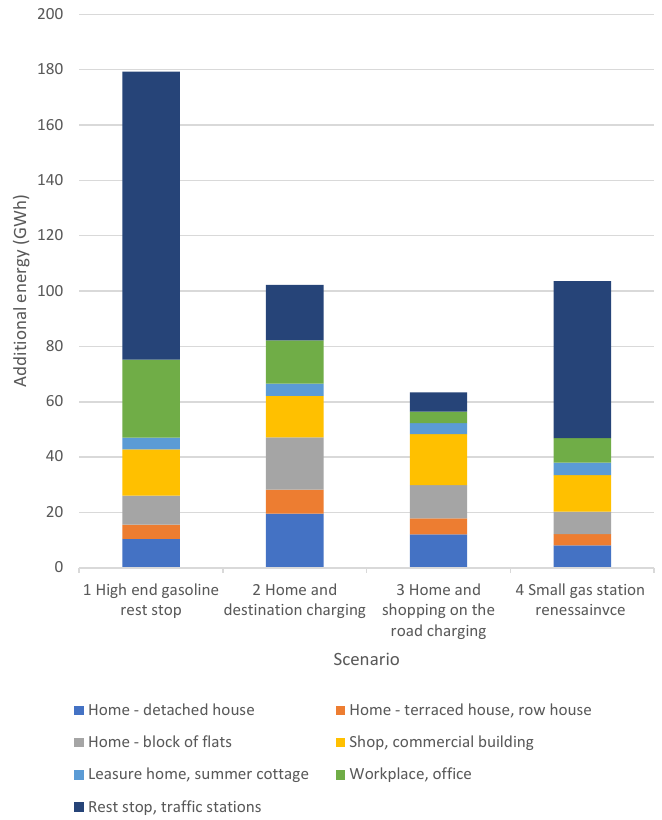
Figure 6. Additional energy requirement divided according to user category.